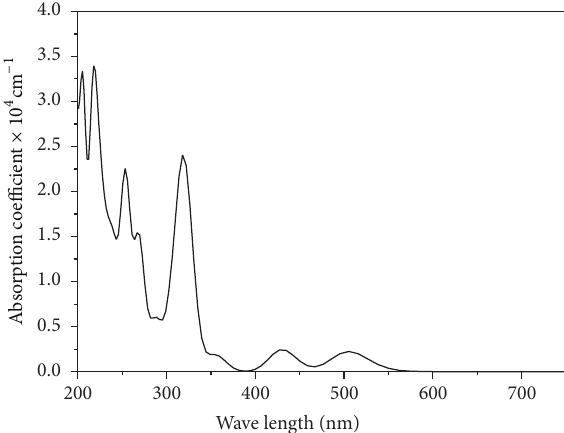
Figure 5: Calculated absorption coefficient of Ag 3 AsO 4